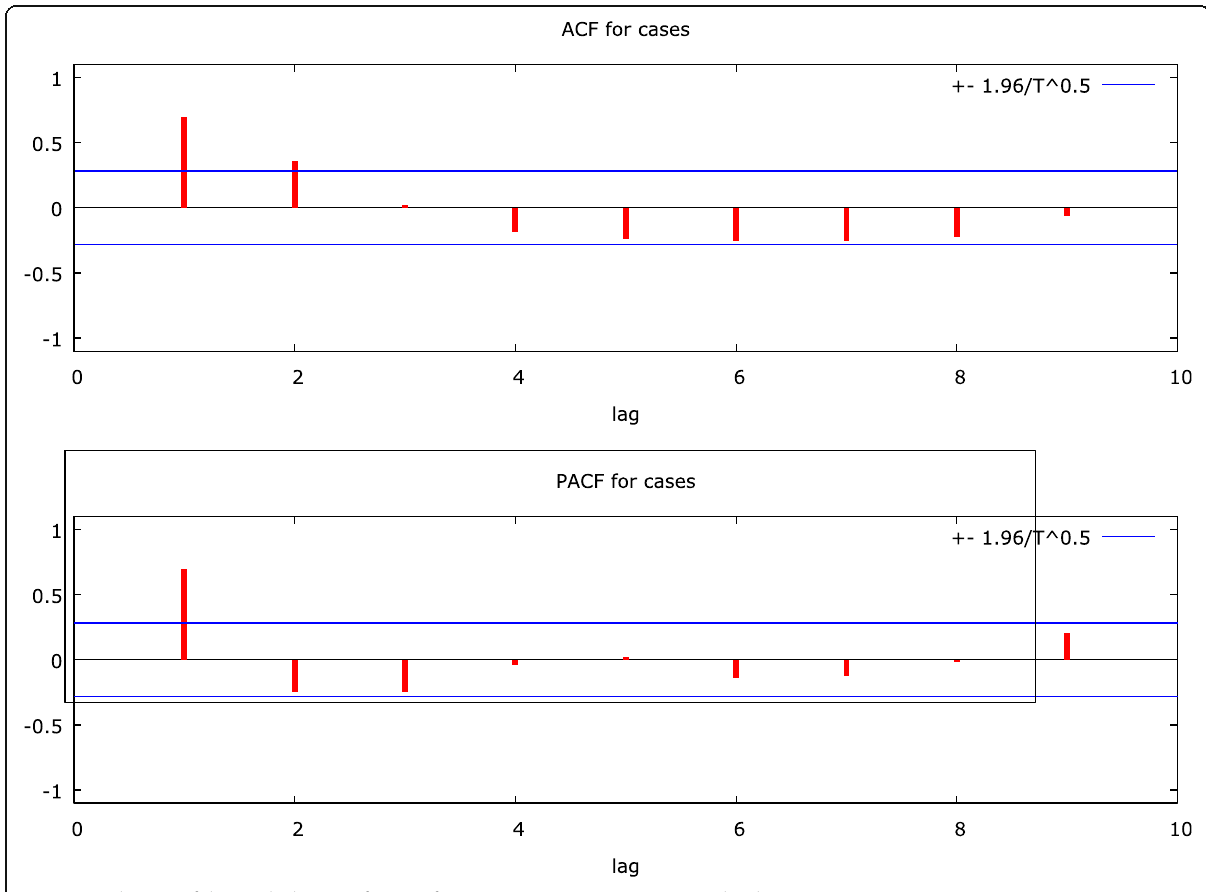
seasonal auto-regression function, D seasonal difference, Q seasonal moving